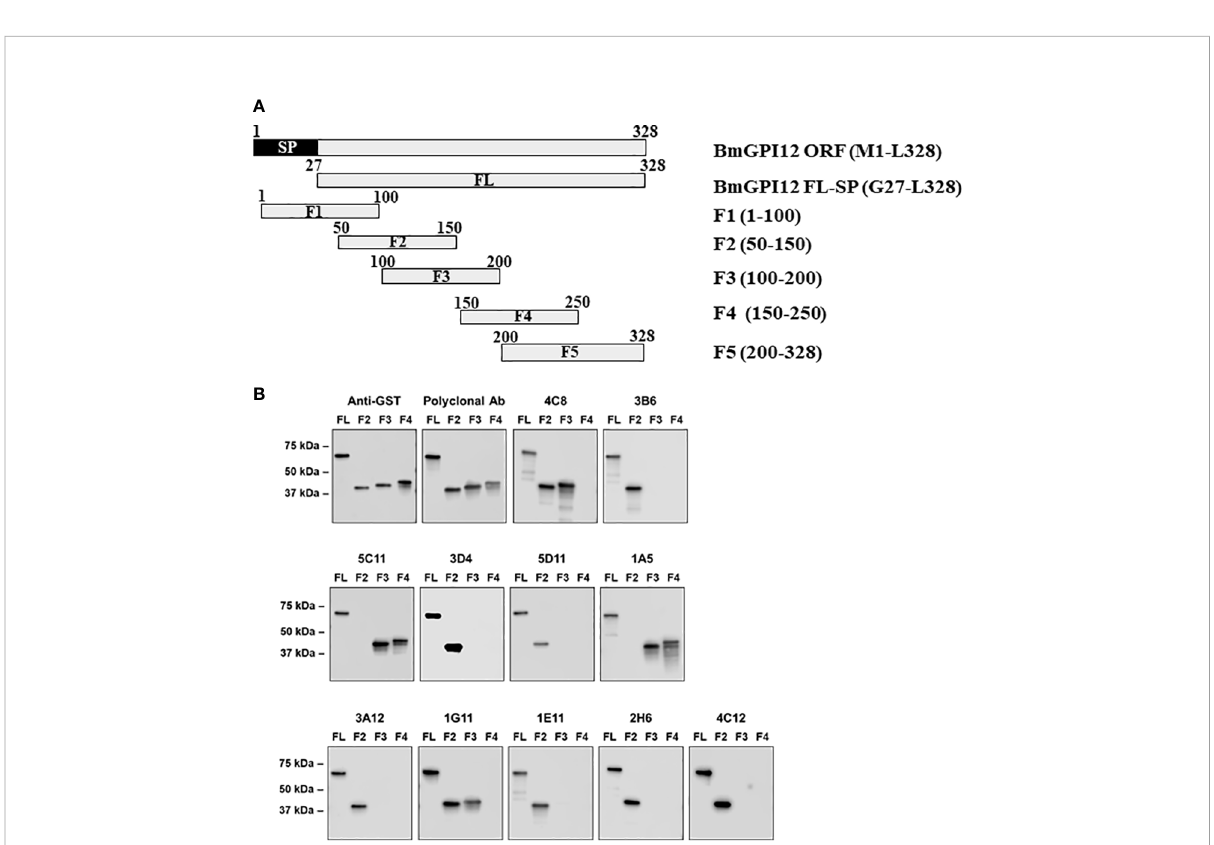
FIGURE 3 Mapping of MAb binding to speci fi c BmGPI12 fragments. (A) Schematic diagram of BmGPI12 and its sub-fragments. (B) Western blot analysis using anti-GST or different anti-BmGPI12 MAbs against full length (FL) BmGPI12 or sub-fragments F2, F3 and F4.